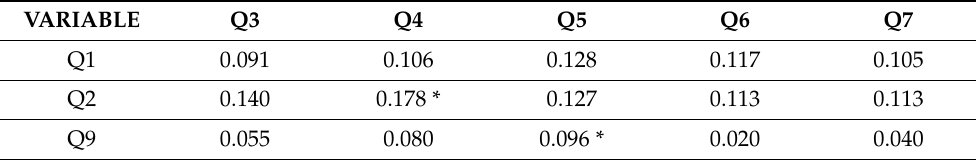
Table 4. Contingency coefficients (Pearson’s coefficient) for using environmental criteria in everyday life, awareness of SRI, and pro-ecological decisions vs. SRI decisive criteria. VARIABLE